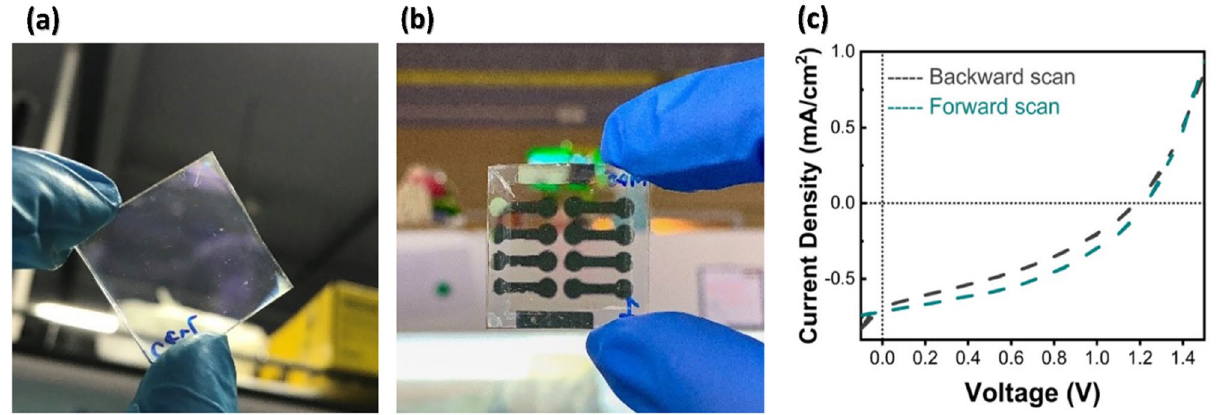
Figure 6. ( a ) Transparent film image, ( b ) Full device structure (FTO/ c -TiO 2 /1.5% Cs/Spiro-OMeTAD/Au), and ( c ) Current–voltage curve of 0.8 M.